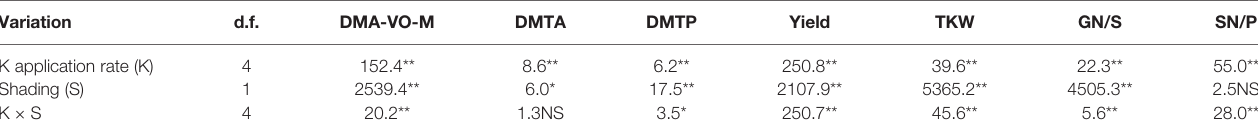
TABLE 1 | F -values from two-way ANOVA on the effects of potassium rate (K0, K50, K100, K150, and K250) and shading treatment (no shading, shading 10 days after anthesis) on DMA-VO-M, DMTA, DMTP, grain yield, TKW, GN/S, and SN/P. Variation